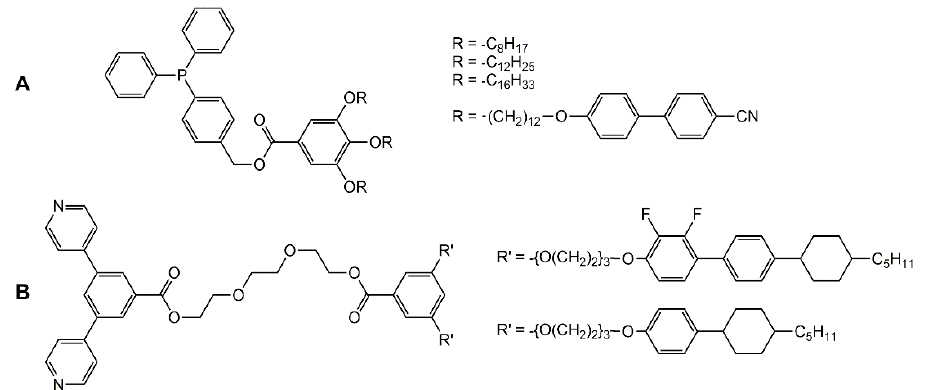
Figure 6. Functionalized diphenyl-phosphine ( A ) and bis-pyridyl ( B ) ligands coordinated to clusters [32,33].